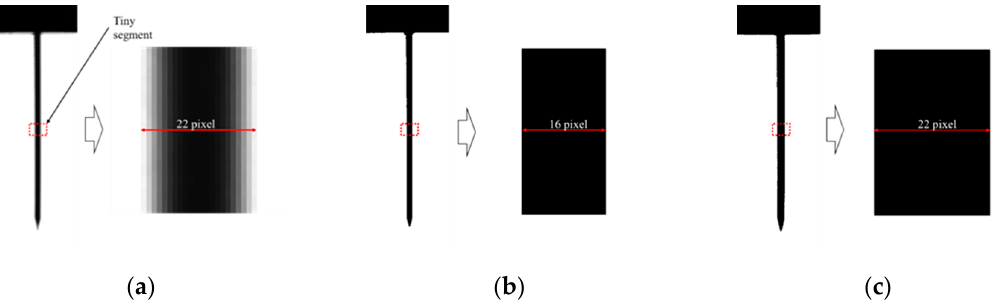
Figure 6. Images of the tiny segments of the cutting blade for thickness comparison for ( a ) the acquired;